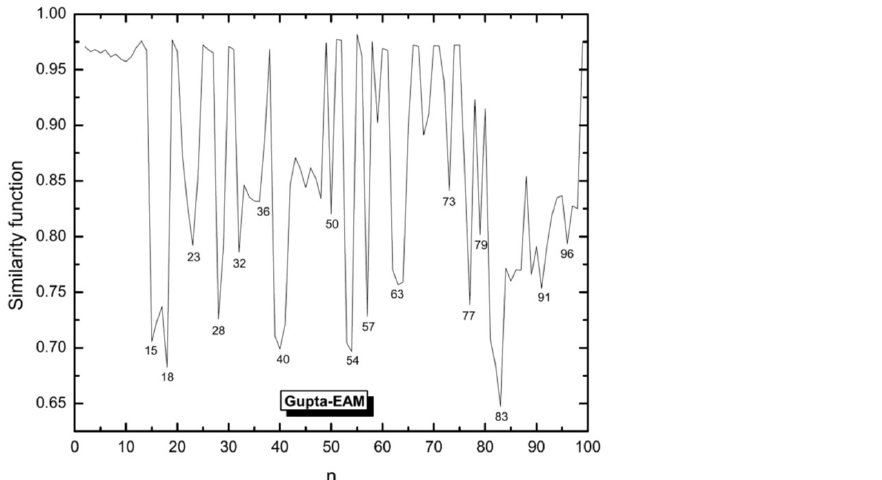
Figure 5. Similarity function for silver clusters calculated using the EAM and the n -body Gupta poten- tial. Also the applied global optimization methods were different: BH for EAM and Aufbau/Abbau method for Gupta potential. The similarity function is based on the radial